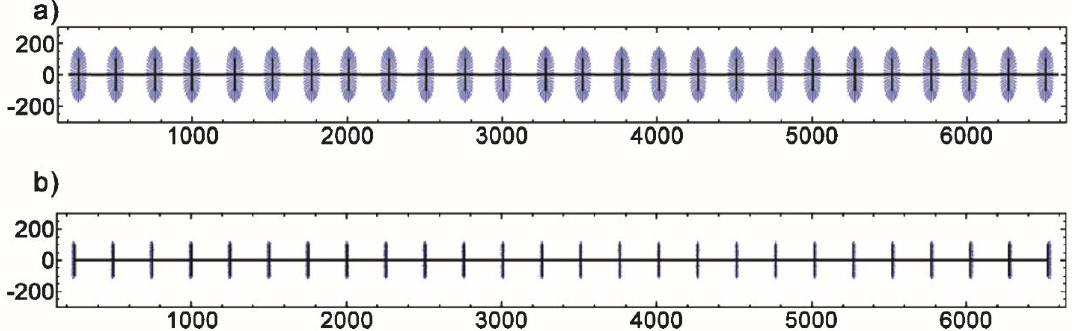
Figure 1. Particle paths (blue) after 1 month of production for a hydraulic fractured in the Permian Basin well. The hydraulic fracture stages are 250 ft apart and have a half-length of 100 ft. (a) DRV around individual hydraulic fractures (b) DRVs in a low productivity well [18]. (Reproduced with permission from SEG, 2020.).